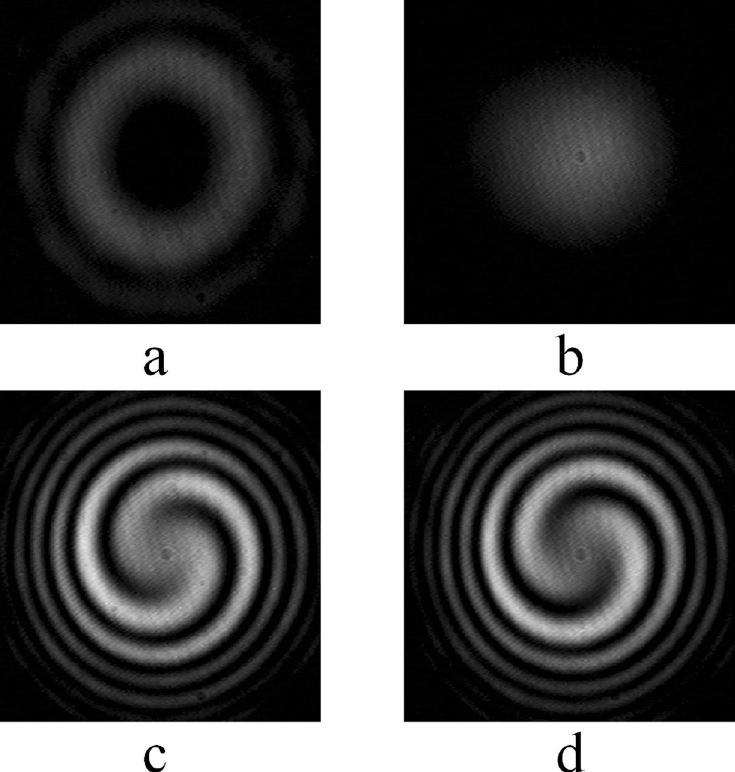
Figure 4. ( a ) I obj ( r , φ ): the intensity of pre-settled OAM mode beam (objective beam), ( b ) I ref ( r , φ ): the intensity of reference light beam, ( c ) I inter 1 ( r , φ ) and ( d ) I inter 2 ( r , φ ): interference intensities of objective beam and reference